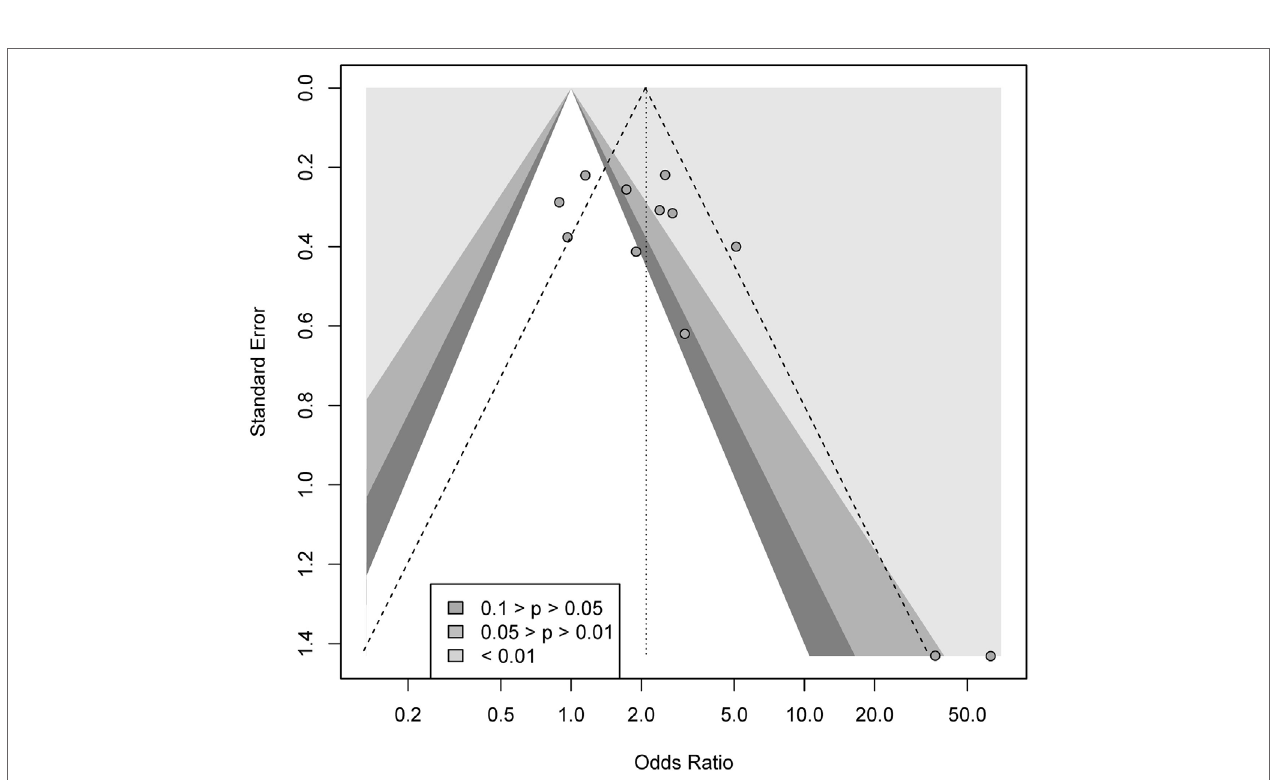
FigURe 3 | Contour-enhanced funnel plot for gambling.